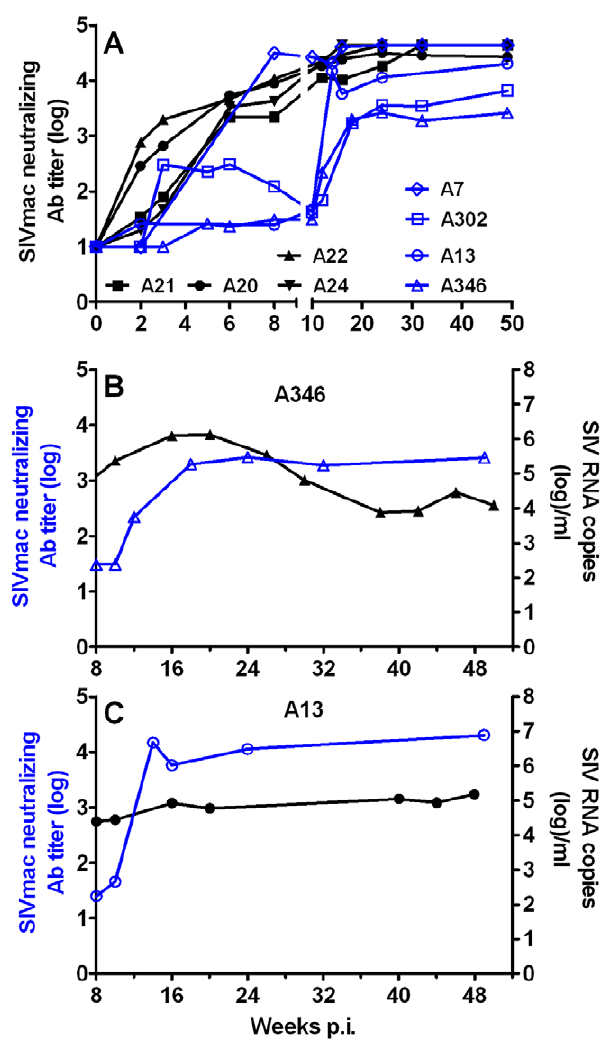
Figure 11. CD8 + and CD20 + lymphocyte depletion delays the generation of neutralizing antibodies in SIV agmVer90 -infected AGM. A neutralizing antibody assay using tissue culture lab-adapted SIV mac251 was utilized to detect neutralizing Ab in historical control (black symbols) and CD8 + and CD20 + lymphocyte-depleted SIV agmVer90 - infected vervet AGM ( A ). Impact of delayed appearance of neutralizing Ab on set point viremia in two long-term B cell-depleted animals (A346: B ; A13: C ).